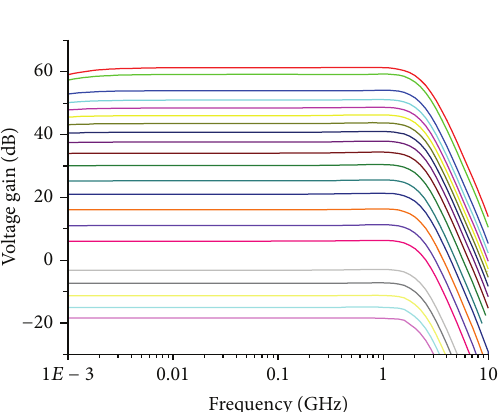
Figure 10: Layout of the VGA.